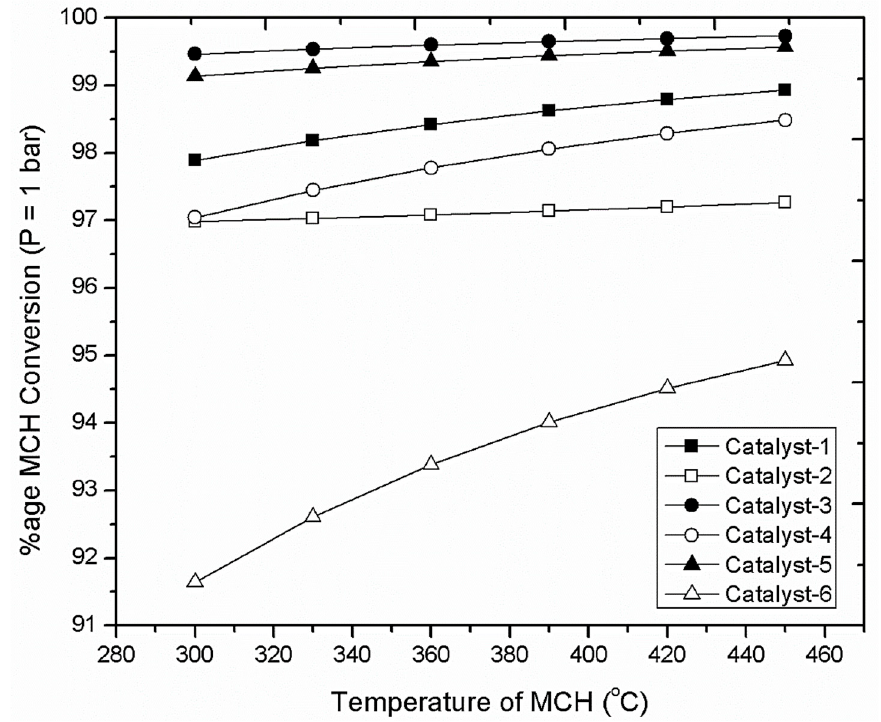
Figure 3. Effect of catalyst category on percentage of MCH conversion at P = 1 bar, H 2 /MCH = 0.5. Figure 3. E ff ect of catalyst category on percentage of MCH conversion at P = 1 bar, H